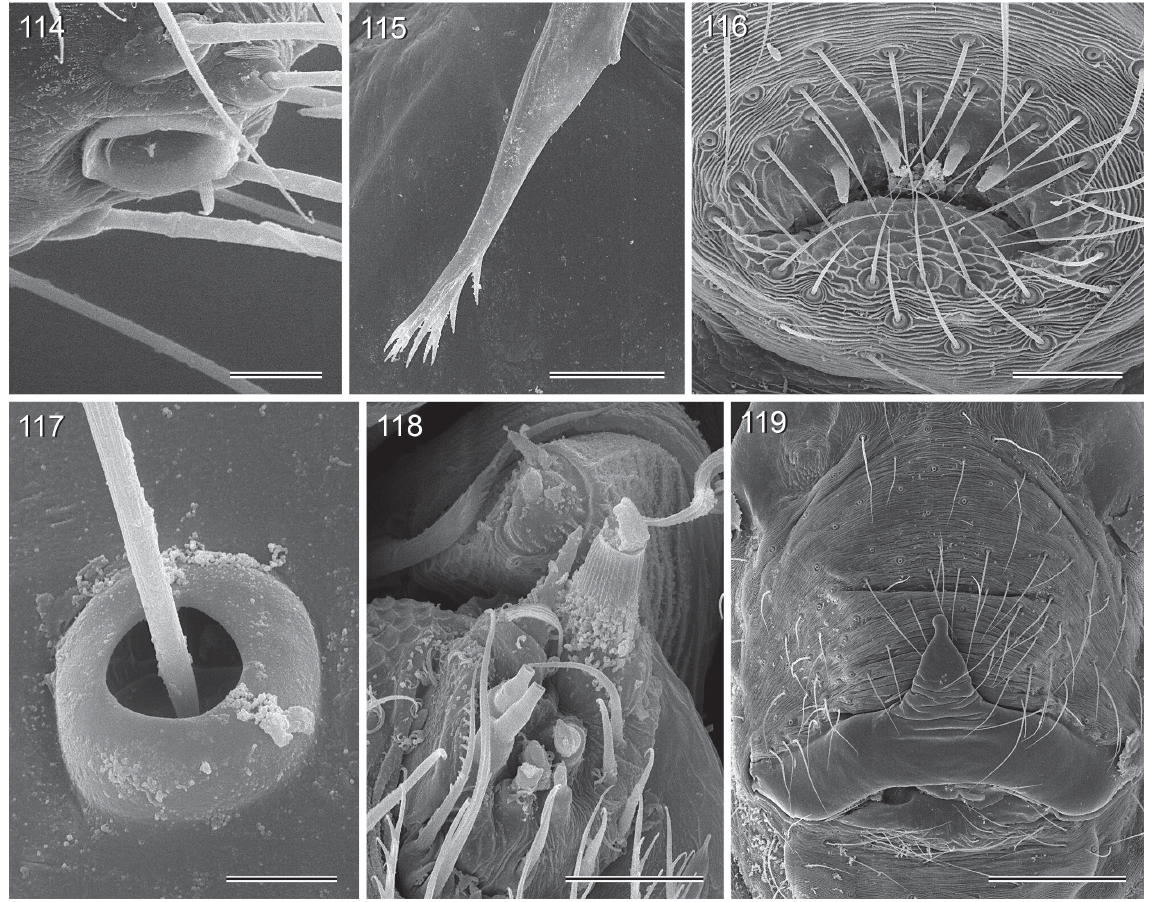
Figs 114–119. Pholcus tambunan Huber sp. nov., SeM micrographs (ZFMK, Ar 15711, 15715). 114 . Male left palpal tarsal organ. 115 . Tip of left embolus. 116 . Male gonopore. 117 . Base of trichobothrium on male palpal tibia. 118 . Female ALS. 119 . Epigynum, ventral view. Scale bars: 114, 118 = 20 µm; 115 = 50 µm; 116 = 40 µm; 117 = 8 µm; 119 = 200